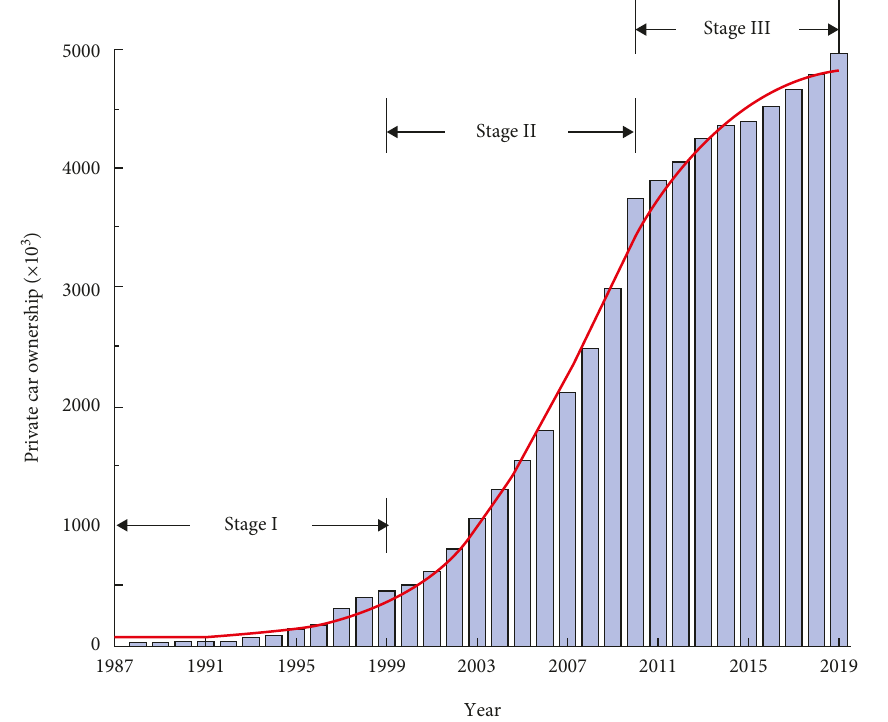
Figure 1: Private car ownership in